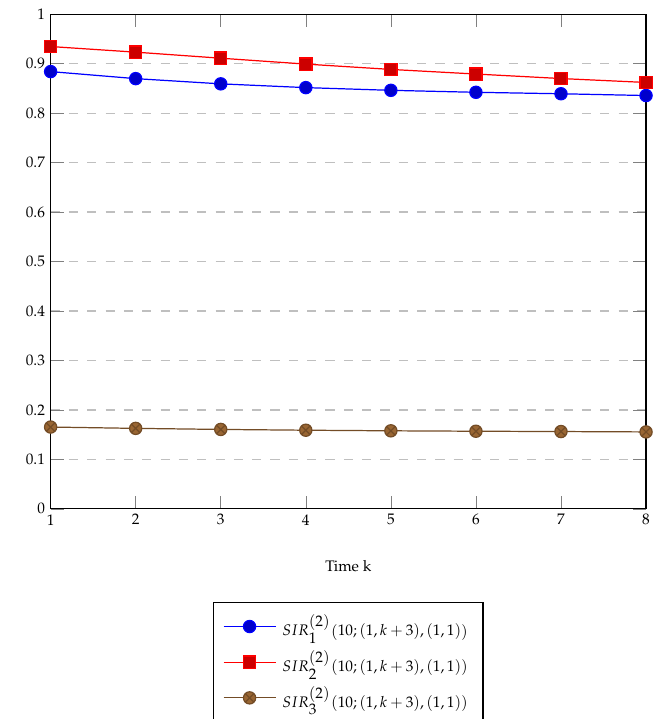
Figure 3. Sequential interval reliability plot with intervals moving apart.